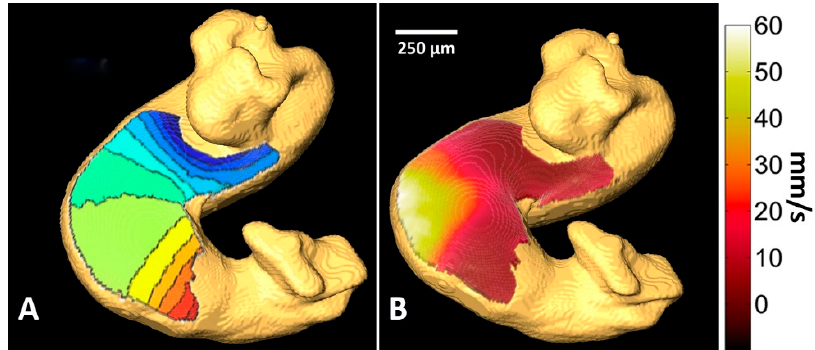
Figure 8. OM data projected onto a 3D surface map [226]. OM data was obtained from HH stage 15 quail embryo hearts. ( A ) The activation isochrome map obtained using data from OM was projected onto a 3-D structural map of the tubular heart obtained by OCT. Activation begins in the atria at the top and the outflow tract at the bottom with the conduction propagating from blue to red (early to late) regions with each line representing a 10-ms interval. The AVJ, mapped in blue, has slower conduction than the ventricle in green. ( B ) Conduction velocity mapped in 3D shows a hot spot of highest conduction velocity (yellow) on the outer curvature of the ventricle. Regions around the atrium and outflow tract were not included in the OM analysis because they were out-of-focus.